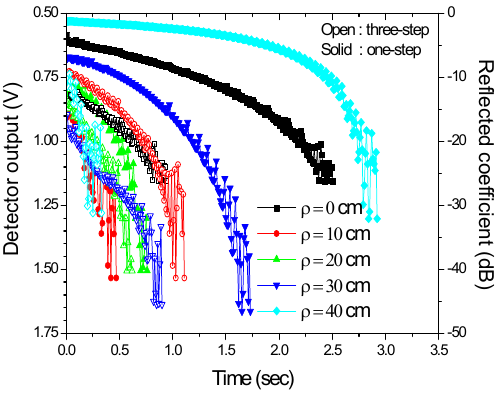
Figure 15. Measured detector output and reflection coefficient versus time for different center-to-center misalignments from ρ = 0 cm to 40 cm, d = 15